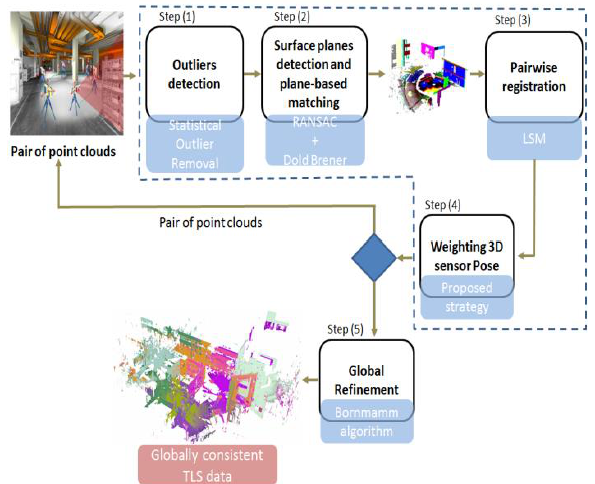
Figure 1. Generic structure of the proposed